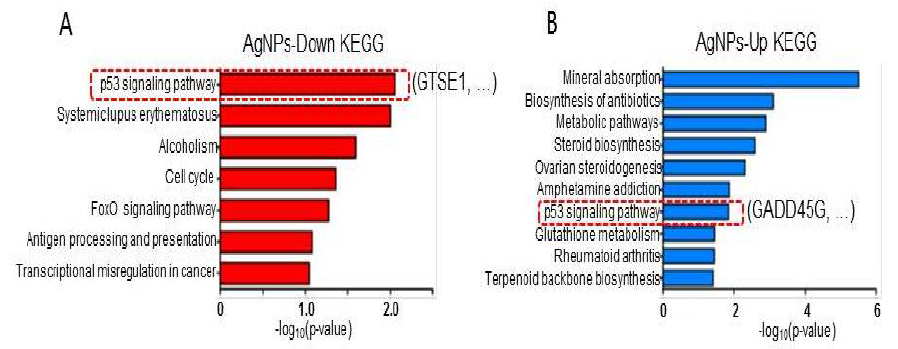
Figure 8. KEGG pathway analysis. ( A , B ) Bar graphs showing biological pathways associated with down- and upregulated genes following AgNP administration. The p53 pathway is highlighted with a representative gene in each case.